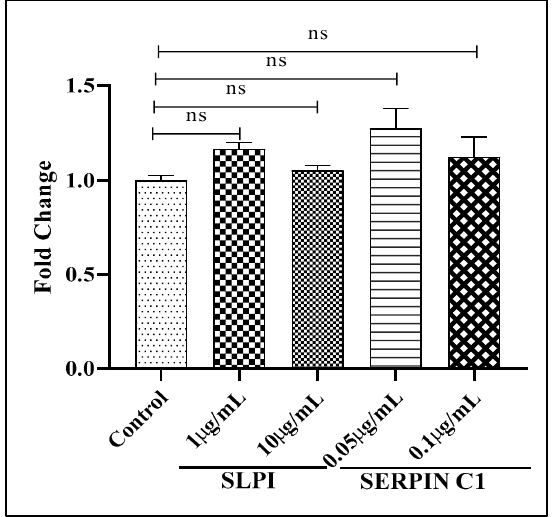
Figure 6. Effects of SLPI and SERPIN C1 on MDMs infection by VSV-G pseudo typed HIV-1 construct.; MDMs (5 × 10 4 cells/well) were pre-treated with 1 µ g/mL and 10 µ g/mL SLPI or 0.05 µ g/mL and 0.1 µ g/mL SERPIN C1 for 2 h and then infected with VSV-G pseudo typed HIV-1 (5 ng/mL p24 units). After 2 h, the unbound virus was removed and replenished with medium containing the same concentrations of SLPI (1 µ g/mL and 10 µ g/mL) or SERPIN C1 (0.05 µ g/mL and 0.1 µ g/mL). MDMs were collected 72 h after infection, and total RNA extracted, and real-time PCR was performed to quantitate HIV-1 replication. Results expressed as mean ± SEM from three independent donors. Mark over the bars indicates non-significant difference with control, ns p > 0.05. p -values were generated by one-way ANOVA with multiple comparisons.